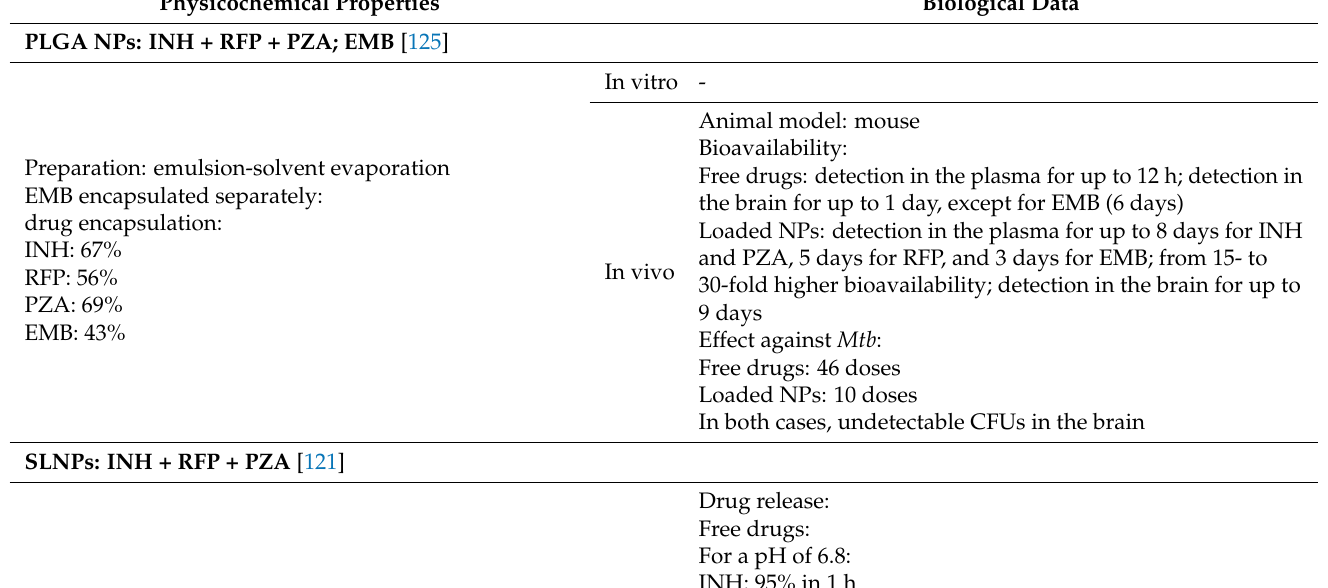
Table 1. Cont. Physicochemical Properties Biological